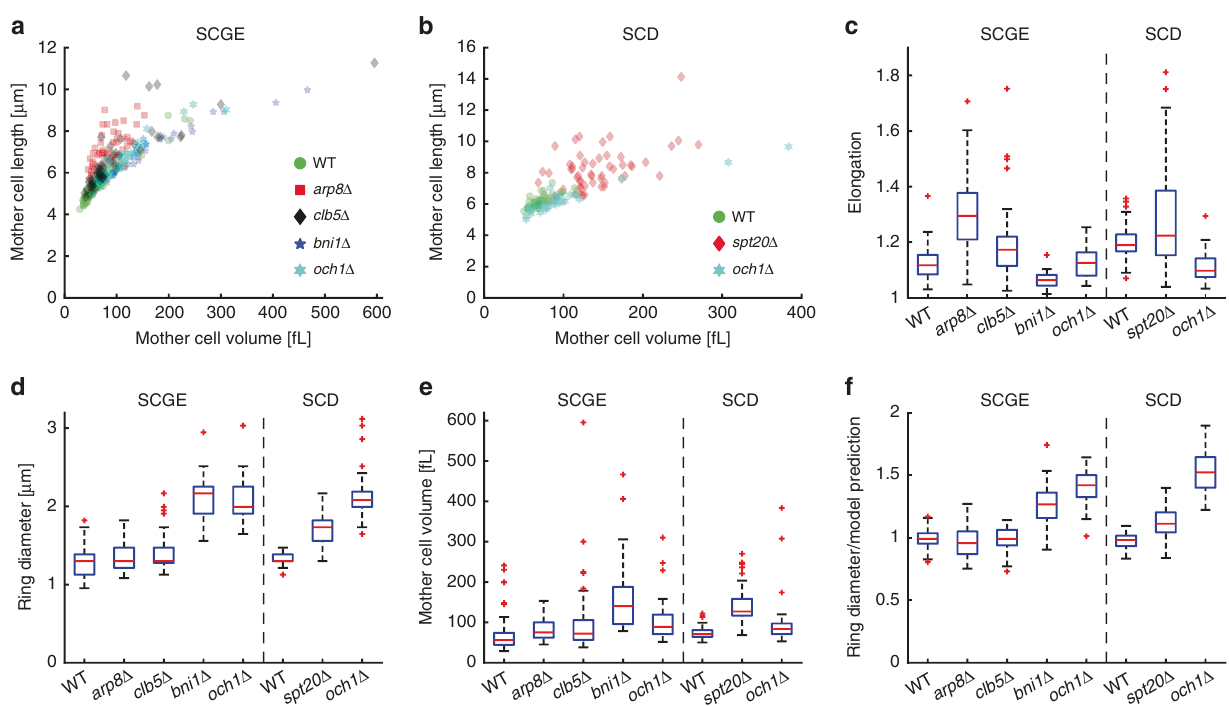
Fig. 8 Analysis of the septin ring diameter in geometry mutants. Cell volume and septin ring diameter based on Cdc10-mCitrine fl uorescence were measured in haploid geometry mutants grown on SCGE ( arp8 Δ (65 cells pooled from two independent experiments), clb5 Δ (52 cells pooled from two independent experiments), bni1 Δ (35 cells pooled from two independent experiments) and och1 Δ (46 cells pooled from three independent experiments)) or SCD ( spt20 Δ (55 cells pooled from three independent experiments) and och1 Δ (33 cells pooled from two independent experiments)) and compared with wild-type haploids (106 cells and 52 cells, pooled from three and two independent experiments, respectively). Cell length along the major axis is shown as a function of cell volume for cells grown on SCGE ( a ) or SCD ( b ). c Boxplots showing the distribution of cell elongation, which we de fi ne as cell length divided by the cube root of volume, normalized such that it is 1 for a sphere. d Boxplots showing the distribution of septin ring diameters. For each cell, the median ring diameter during the time when the ring is detected is measured. e Boxplots of the median cell volume during that time. f For each cell, we compare the measured ring diameter to the value expected for wild-type cells with the same mother cell volume based on the power law fi t obtained for wild-type and inducible-Whi5 cells shown in Figs. 2c (SCGE) and 3a (SCD). Boxplots depict the distribution of the ratios of measured and expected ring diameters. Boxplots depict medians, and 25 and 75 percentiles. Whiskers denote extreme values still within 1.5 interquartile ranges, red symbols denote outliers. Source data are provided as a Source Data fi